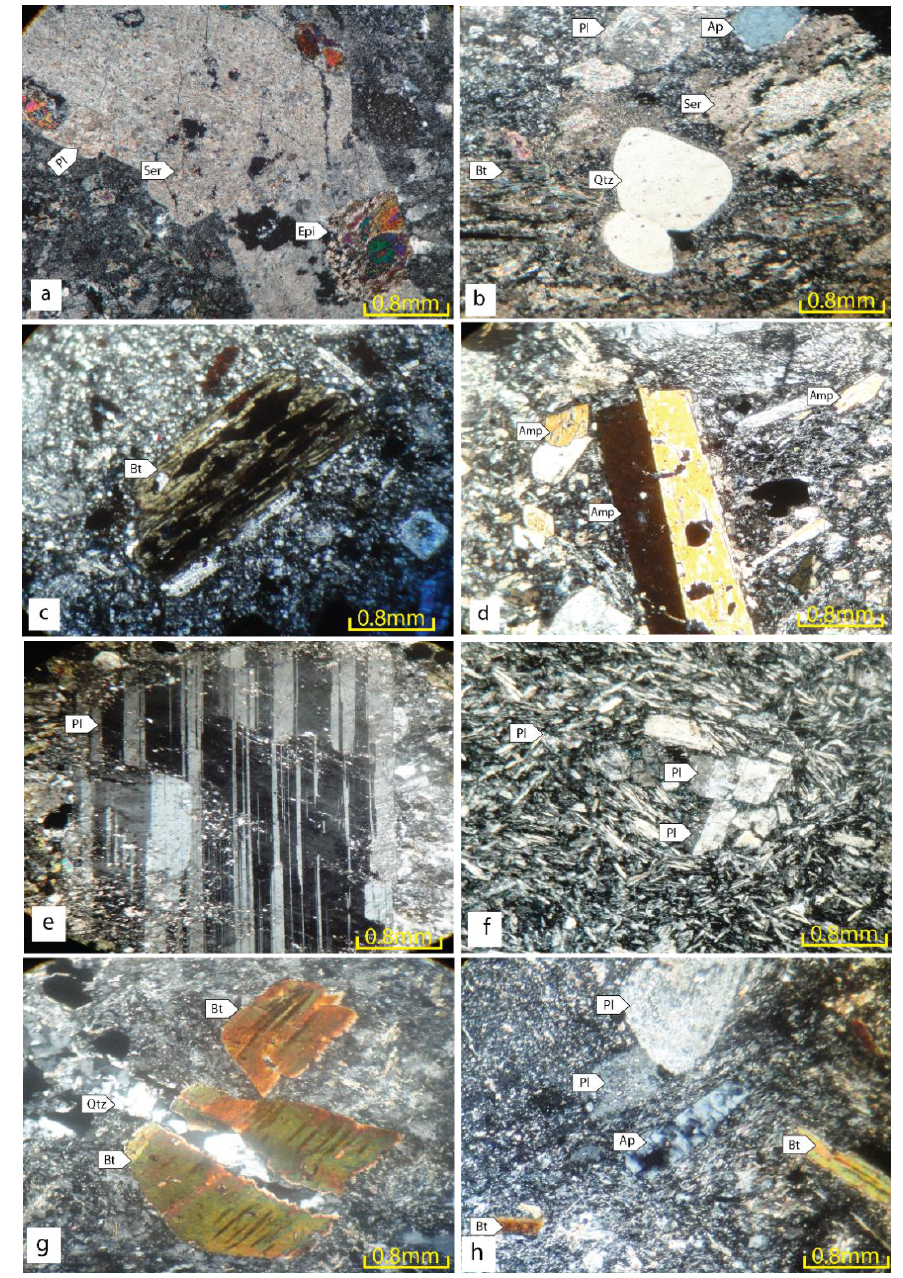
Figure 7. Photomicrographs (cross polarized light) show textures and mineral assemblages of the Sungun stock and post-mineralization dykes. ( a ) Alteration of plagioclase to sericite in quartz-monzonite; ( b ) subrounded “quartz eye” within altered plagioclase and biotite groundmass; quartz diorite dyke (DK1a); ( c ) Alteration of biotite to chlorite in quartz diorite; ( d ) amphibole with Carlsbad Twinning; ( e ) megacryst of plagioclase in diorite (DK3); ( f ) flow texture and cognate inclusion of feldspars in microdiorite (MDI); ( g ) megacryst of biotite in lamprophyre dyke; and ( h ) phenocryst of apatite in lamprophyre. Abbreviation: Amp = Amphibole, Chl = Chlorite, Am = amphibole, Bt = biotite, Pl = plagioclase, Ser = Sericite, Qtz = quartz, and Ap = apatite.